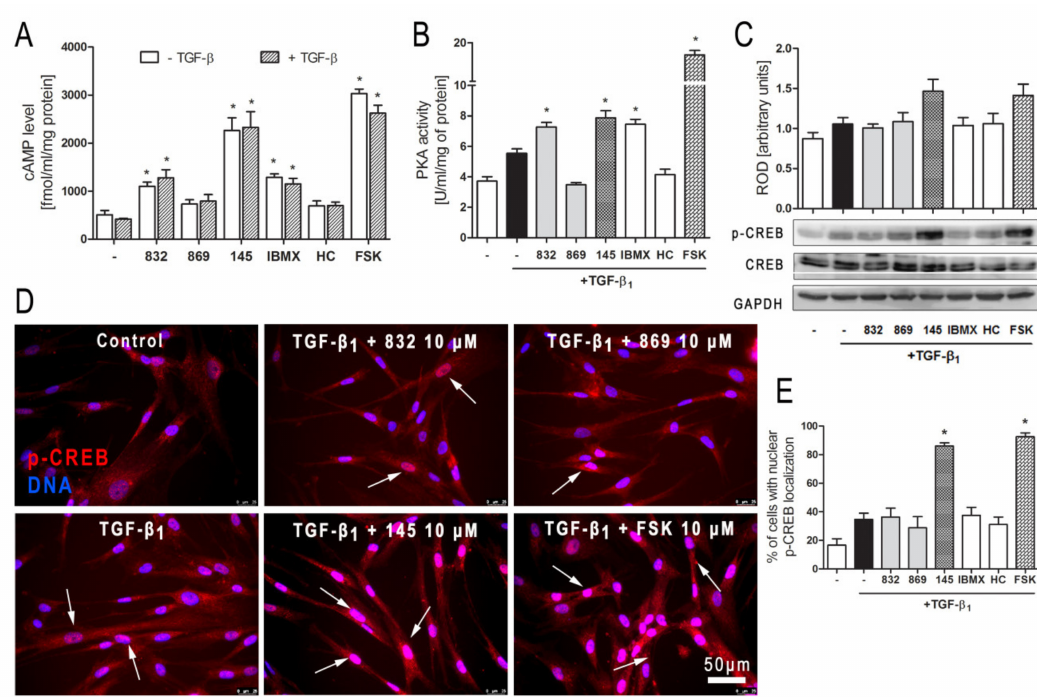
Figure 7. Compound 145 activates cAMP / PKA / CREB dependent pathway in TGF- β 1 -induced MRC-5 cells. ( A ) Lung fibroblasts were cultured for 24 h and then serum-deprived for 2 h. The cAMP level was measured after 30 min of incubation with the studied compounds (10 µ M) and TGF- β 1 (5 ng / mL). Each bar represents the mean ( ± S.E.M.) The cAMP concentration (fmol / mL / mg of protein; n = 4). ( B ) Protein kinase A activity in MRC-5 was determined after 30 min of incubation with the studied compounds (10 µ M), and 30 min of incubation with TGF- β 1 ( n = 4). ( C ) Representative immunoblot and densitometry analysis of p-CREB in MRC-5 ( n = 4). The ROD signal was normalized to the GAPDH control level. Each bar represents the mean value ( ± S.E.M.). ( D ) Immunofluorescence staining for p-CREB protein: MRC-5 were fixed, permeabilized, blocked, and incubated with anti-p-CREB antibody followed by an Alexa Fluor 546 conjugated antibody, nuclei were stained with Hoechst 33342 dye. Microphotographs were taken using a Leica DMi8 microscope, 40 × objective, bar = 50 µ m. ( E ) Cells exhibiting co-localization of p-CREB and nuclear signal were counted in 20 randomly selected fields of view and expressed as a percentage fraction in the entire MRC-5 population. The results were considered statistically significant at the p level of 0.05, against control